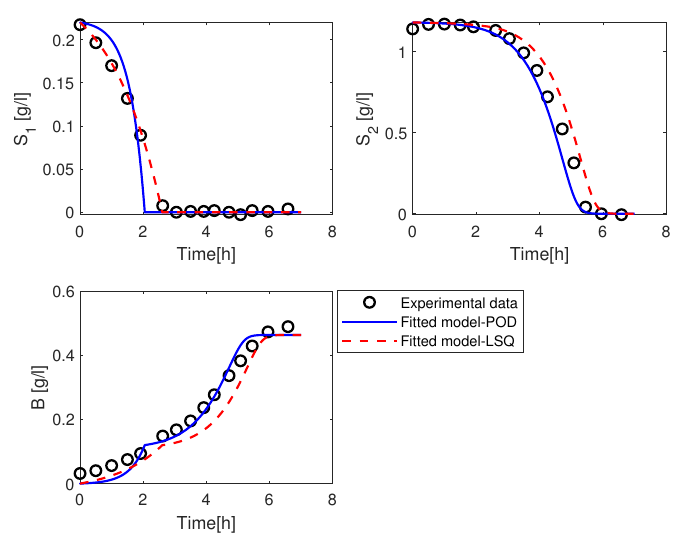
Figure 8. Simulation of the solution of the kinetic model with the parameters value k s 1 , k e 1 , k x 1 and k x 2 using POD method in blue (solid line), LSQ method in red (dashed line), and the experimental data in black (open